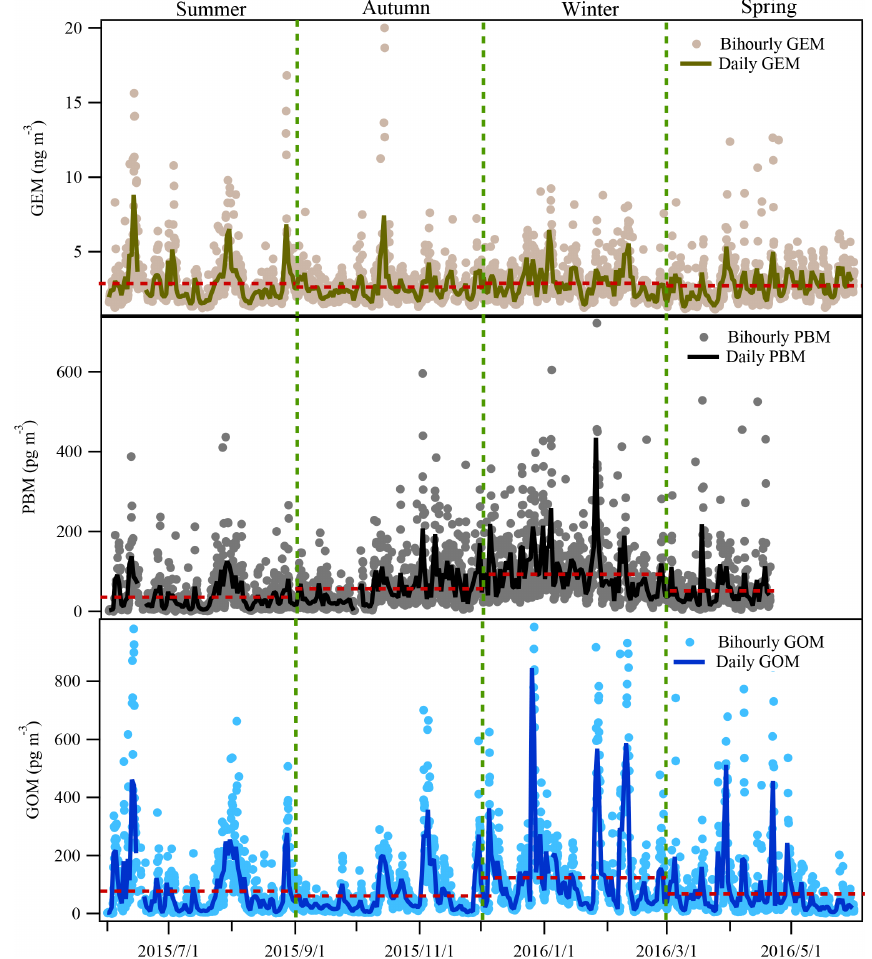
Figure 2. Time series of atmospheric Hg (GEM, PBM, and GOM) concentrations during the whole study period at DSL. The red dashed lines represent the mean concentrations of Hg species in each